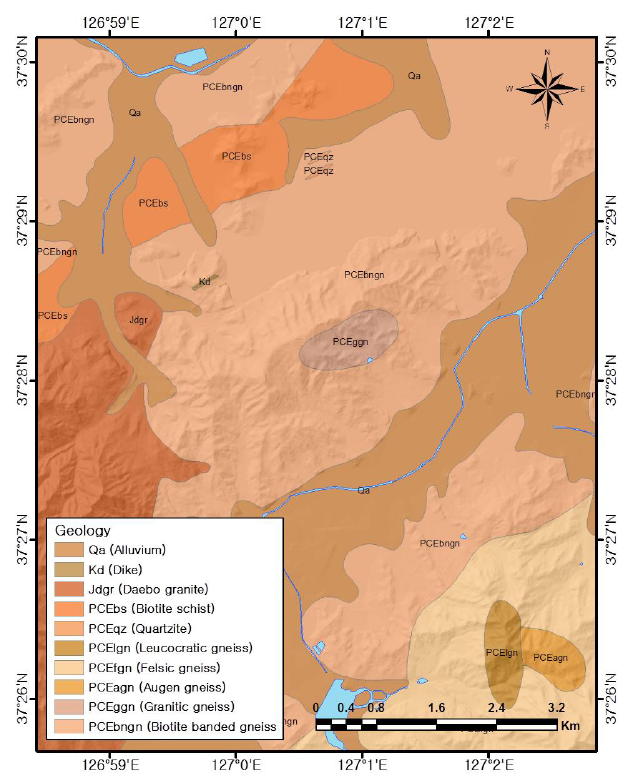
Fig. 2. Geological map of the study